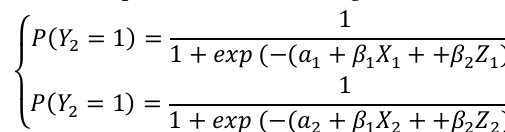
Figure 2. Relationship charts between the dependent variable Y 1 and the two explanatory variables X 1 , X 2 .